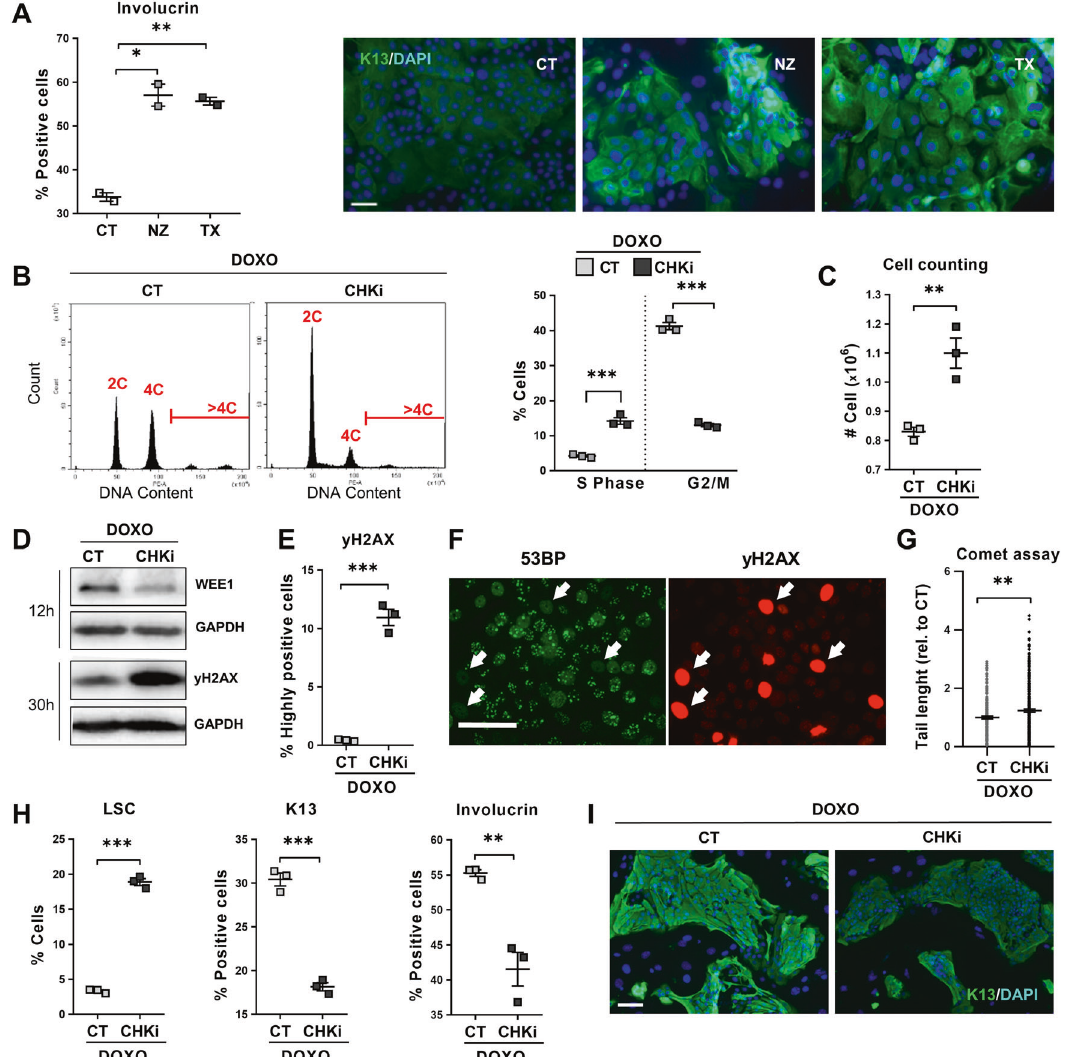
Fig. 6 The G2/M checkpoints drive squamous metaplasia in response to DNA damage. A Human primary lung epithelial cells were treated with the dimethyl sulfoxide vehicle (CT), 20 μ M Nocodazole (NZ, microtubule polimerisation inhibitor) or 200 μ M Paclitaxel (TX, microtubule depolimerisation inhibitor). Left: Percent of CT, NZ, or TX involucrin positive cells, analysed by fl ow cytometry. Right: Immuno fl uorescence for involucrin (green). Blue is nuclear DNA by DAPI. Scale bar, 50 μ m. B – I Human primary lung epithelial cells were treated with 0.07 μ M Doxorubicin (DOXO) and with the dimethyl sulfoxide vehicle (CT) or with 0.5 μ M AZD7762 (CHKi, Chk1/Chk2 inhibitor). B Representative fl ow- cytometry analyses of DNA content after the 24 h treatments as indicated. Plot on the right shows percent of CT or CHKi-treated cells in the S or G2/M phase of the cell cycle, as indicated. C Cell counting of recovered CT and CHKi-treated cells after 48 h treatment. D DNA damage marker γ H2AX and Wee1 by Western blotting in cells treated for 12 or 30 h, as indicated. Glyceraldehyde 3-phosphate dehydrogenase (GAPDH) as loading control. E Percent of highly γ H2AX positive cells, analysed by fl ow cytometry after 24 h. F Double immuno fl uorescence for 53BP (green) and γ H2AX (red) in CHKi-treated cells at 24 h. Scale bar, 50 μ m. White arrows point at strongly positive γ H2AX cells lacking 53BP foci (typical of active DNA repair). G DNA fragmentation as analysed by comet assays after 24 h with the indicated treatments, measured by tail length relative to CT ( n = 196 – 298). H Percent of low light scatter (LSC, left) cells, keratin K13 positive cells (centre) or involucrin positive cells (right), as analysed by fl ow cytometry (K13, 24 h-treatment; LSC and involucrin, 48 h-treatment). I Immuno fl uorescence of CT and CHKi- treated cells for keratin K13 (green) after 24 h treatments. Blue is nuclear DNA by DAPI. Scale bar, 100 μ m. Positive cells by fl ow cytometry were gated according to negative isotype antibody control. Data are mean ± SEM of duplicate or triplicate samples, representative of 2 – 3 independent experiment from two different human individuals with similar results. *** p ≤ 0.001, ** p ≤ 0.01, * p ≤